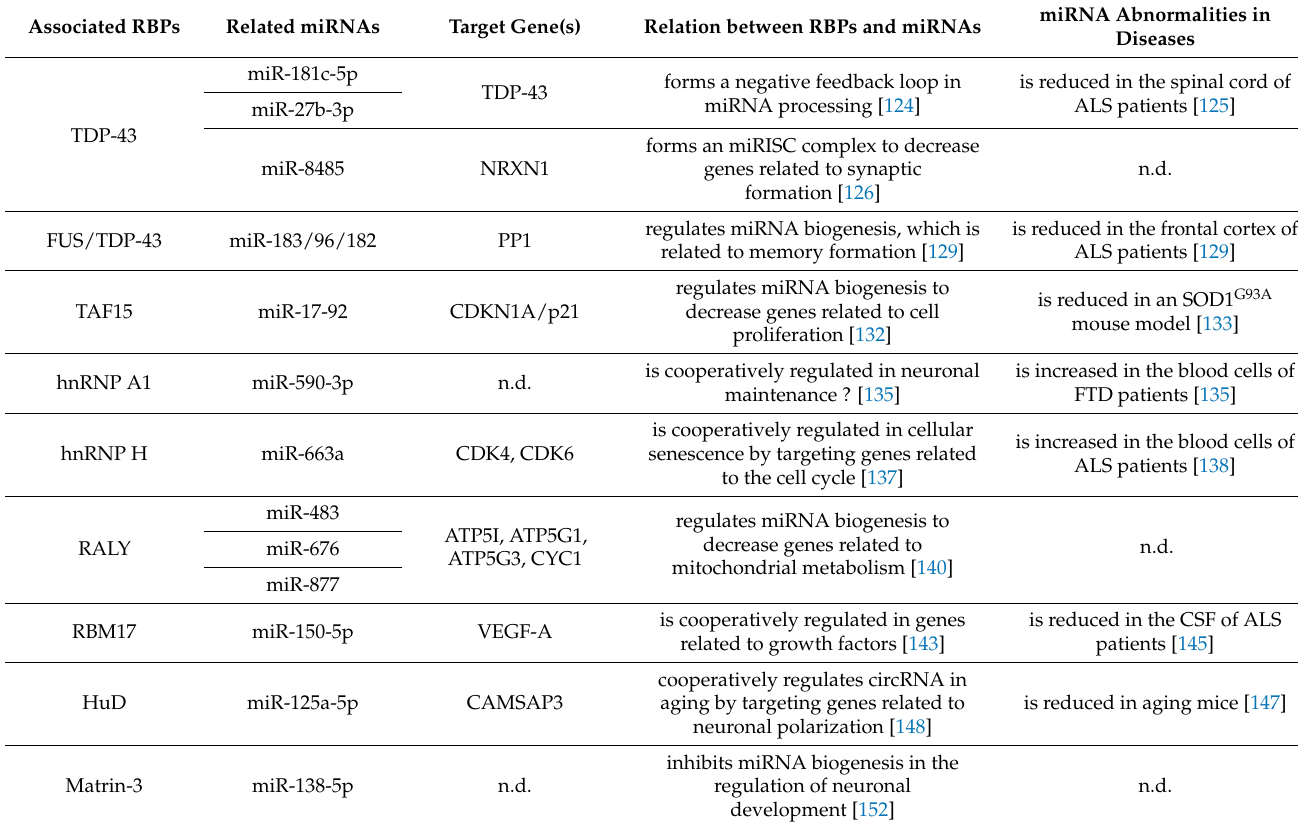
Table 2. List of interactions between the RBPs and miRNAs in the ALS and the